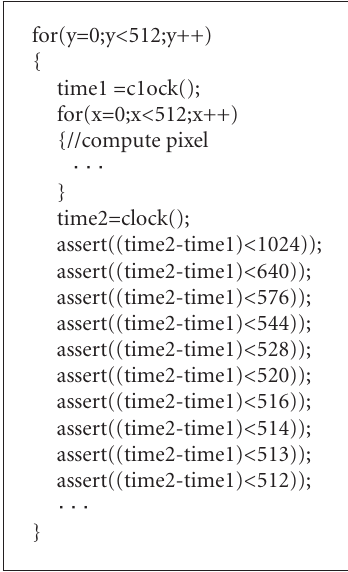
Algorithm 2: Adding timing assertions individually to backprojec- tion.